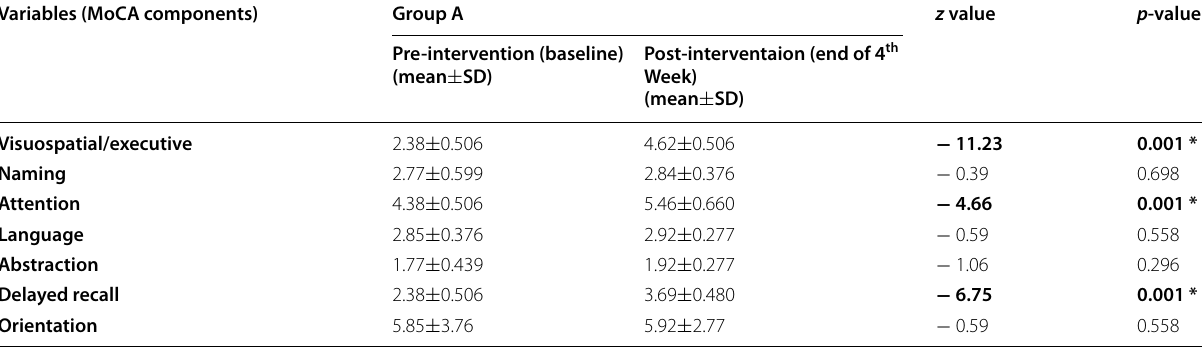
*Significant p -value ( p 0.05) ≤ Table 3 Comparison of mean and standard deviation (SD) of various components of the MoCA score at pre- (baseline) and post- intervention (end of 4th week) in group A Variables (MoCA